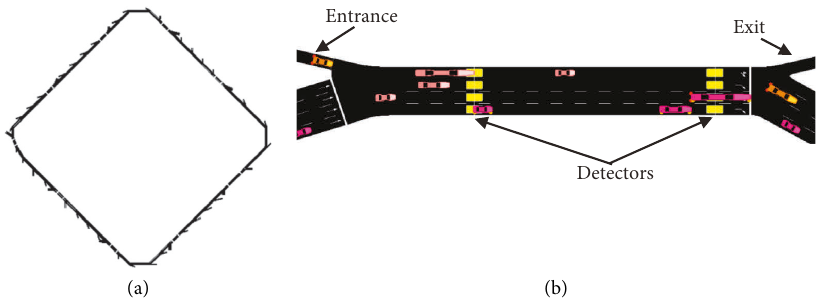
Figure 4: Design figures of simulation modeling. (a) Design figure of the road net. (b) Design figure of the road section.